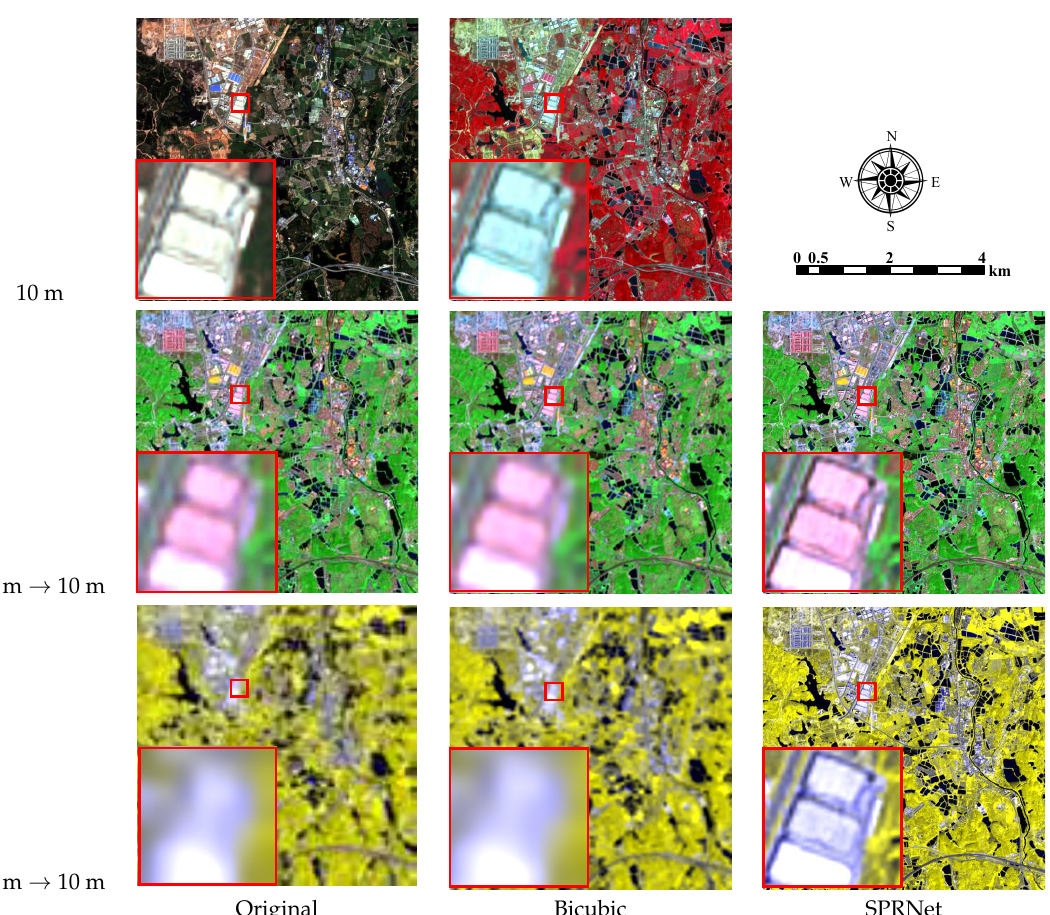
Figure 10. Visual results on real Sentinel-2 data on site 1. 10 m: true RGB (B2, B3, B4) and false RGB (B8, B4, B3). 20 m (B12, B8a and B5 as RGB): original image, up-scaled result to 10 m with bicubic, and sharpening result to 10 m with SPRNet. 60m (B9, B9 and B1 as RGB): original image, up-scaled result to 10m with Bicubic, and sharpening result to 10 m with